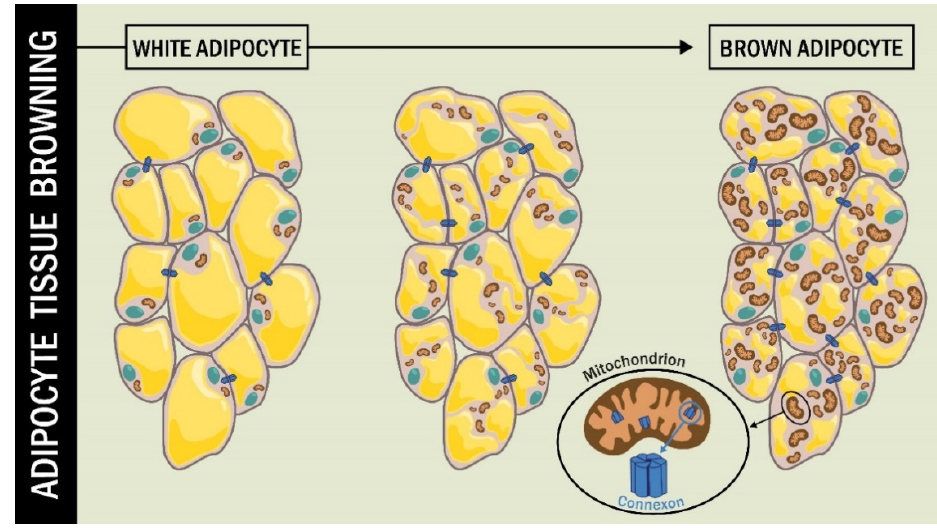
Figure 3. Cx43 during adipocyte tissue browning. During the browning process of WAT, the cell undergoes changes, including an increase in the number and size of mitochondria. In this process, the function of mtCx43 implies a protective role for mitochondrial integrity.